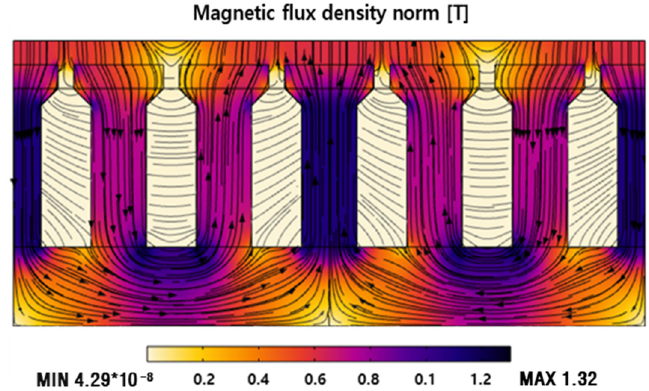
Figure 5. Field distribution and flux density contours of the circuit.